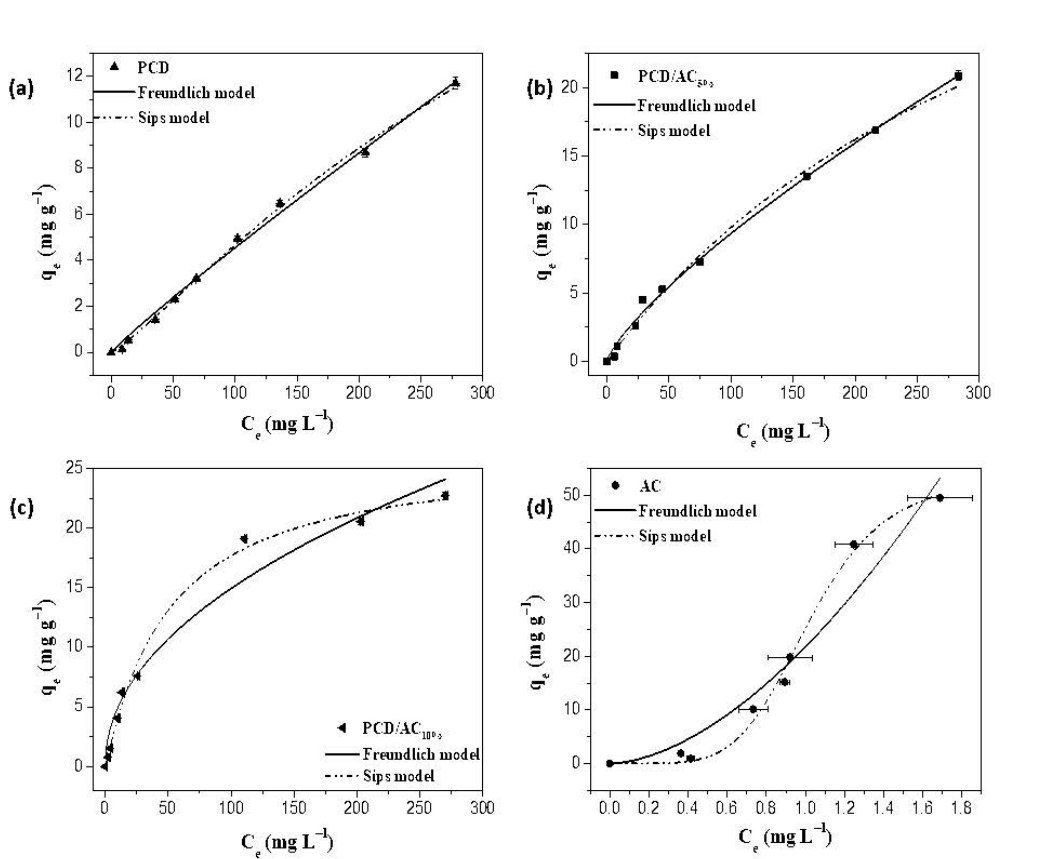
Molecules 2021 , 25 , x FOR PEER REVIEW 10 of 21 Figure 4. Sorption isotherms of IMD onto: ( a ) PCD, ( b ) PCD/AC 5% , ( c ) PCD/AC 10% and ( d ) AC, at 25 ◦ C.